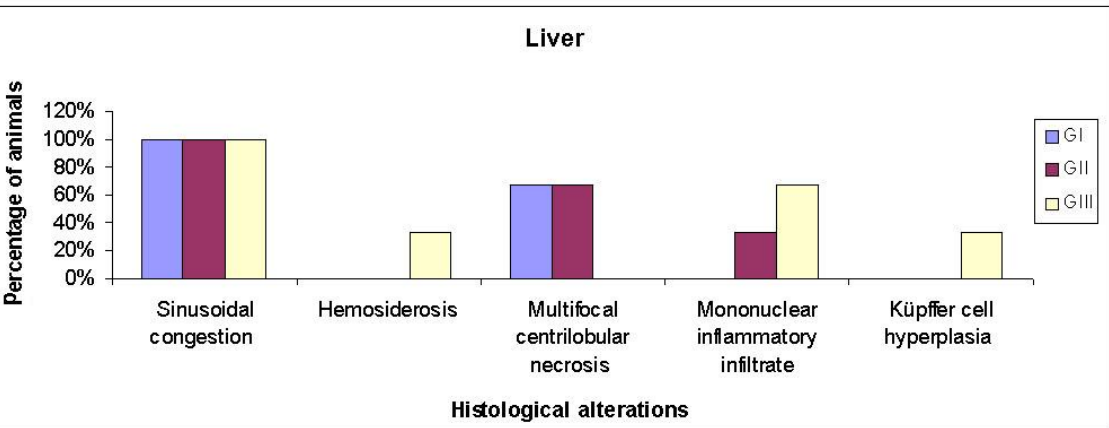
Figure 12. Percentage of animals that developed hepatic lesions.